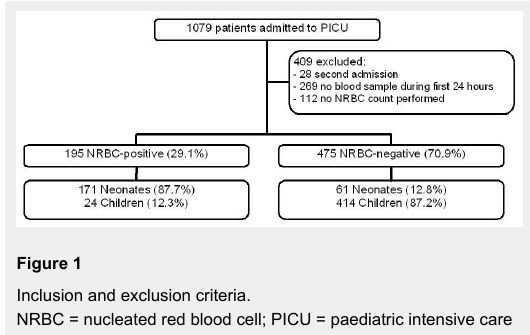
Inclusion and exclusion criteria. NRBC = nucleated red blood cell; PICU = paediatric intensive care